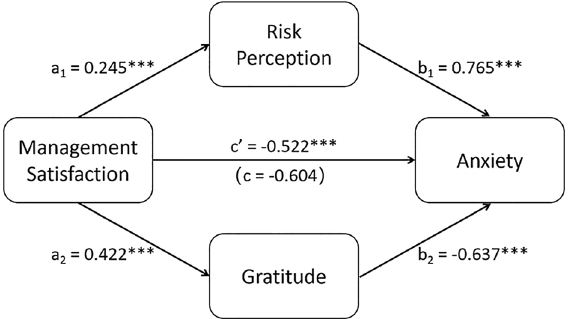
Figure 2. Parallel-multiple mediation of gratitude and risk perception between management satisfaction and anxiety. ***p <